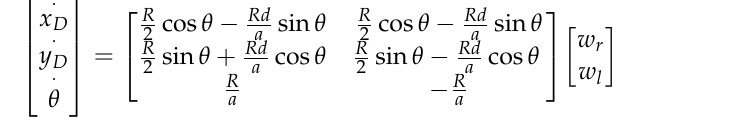
Figure 8. Geometric model of transformed wheel movement. According to the geometric relationship in the figure, when t = T 0 , the relationship between the transformed wheel centers S t= 0 and H t= 0 is 0 0